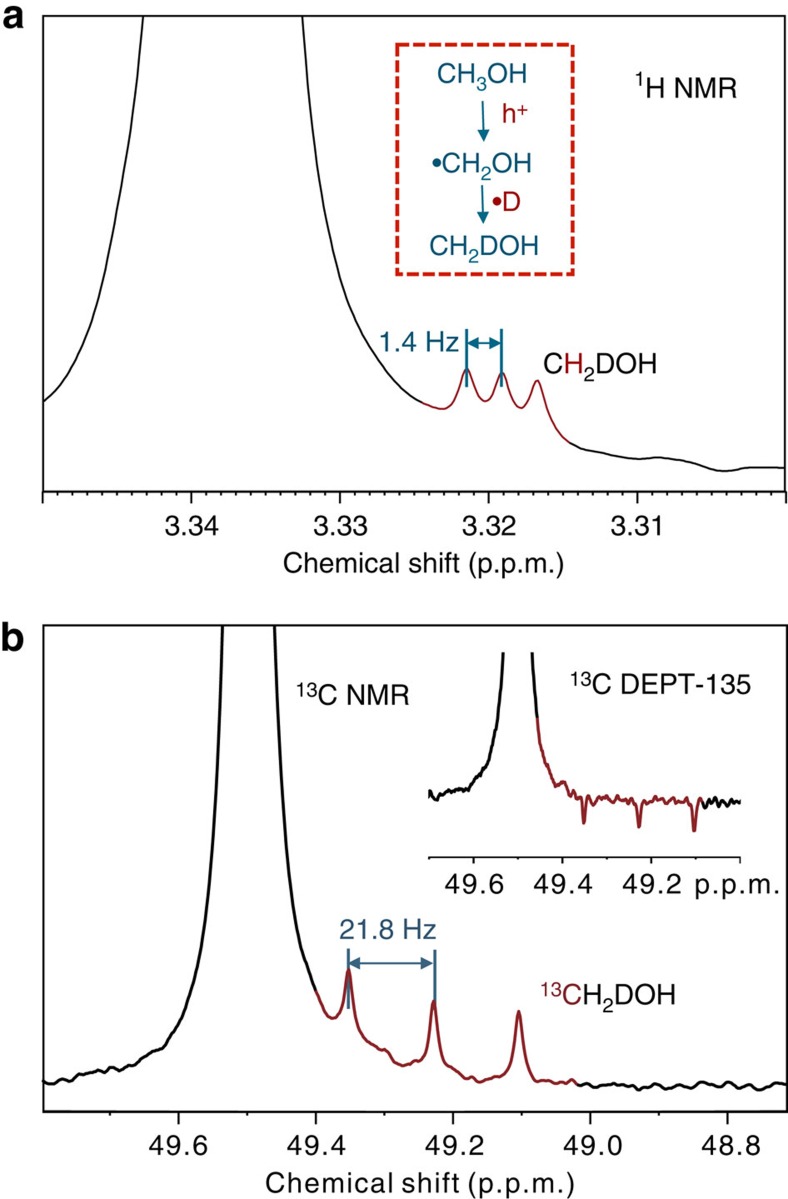
High resolution NMR spectra of as-prepared samples.(a) 1H NMR spectrum of the methanol intermediates after the UV/Vis irradiation. The 1H NMR experiment was acquired from samples containing Pd/TiO2 (2 mg), CH3OH (20 μl) and D2O (500 μl) at 298 K with a 5 s recycle delay and 16 scans after the UV/Vis irradiation for 40 h. (b) 13C NMR spectrum of the methanol intermediates after the UV/Vis irradiation. The 13C NMR experiment was acquired from samples containing Pd/TiO2 (2 mg), 13CH3OH (20 μl) and D2O (500 μl) at 298 K with a 2 s recycle delay and 32 scans after the UV/Vis irradiation for 40 h. Inset is the DEPT-135 NMR spectrum of the as-prepared samples. The DEPT-135 spectrum was acquired from samples containing Pd/TiO2 (2 mg), 13CH3OH (20 μl) and D2O (500 μl) at 298 K with a 1 s recycle delay and 32 scans after the UV/Vis irradiation for 40 h. In the DEPT-135 spectrum, the negative 13C signals indicate that the signals are from the partially deuterated methyl (−CH2D).